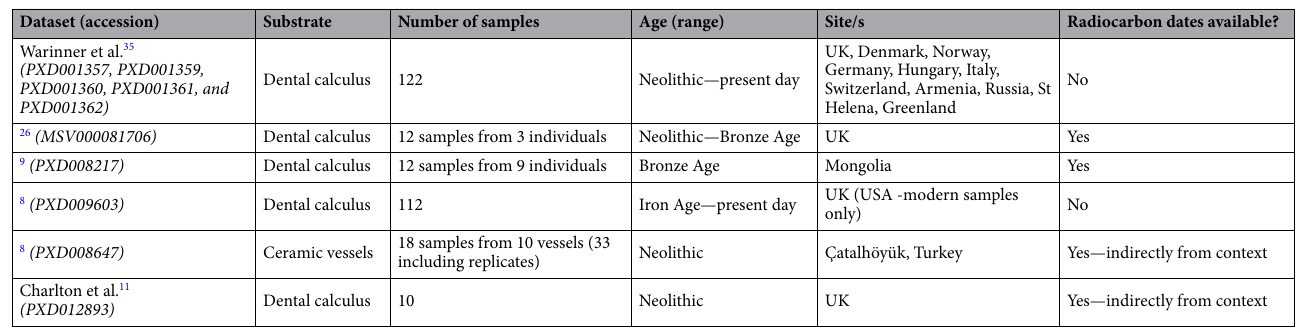
Table 2. Archaeological datasets reanalysed in this